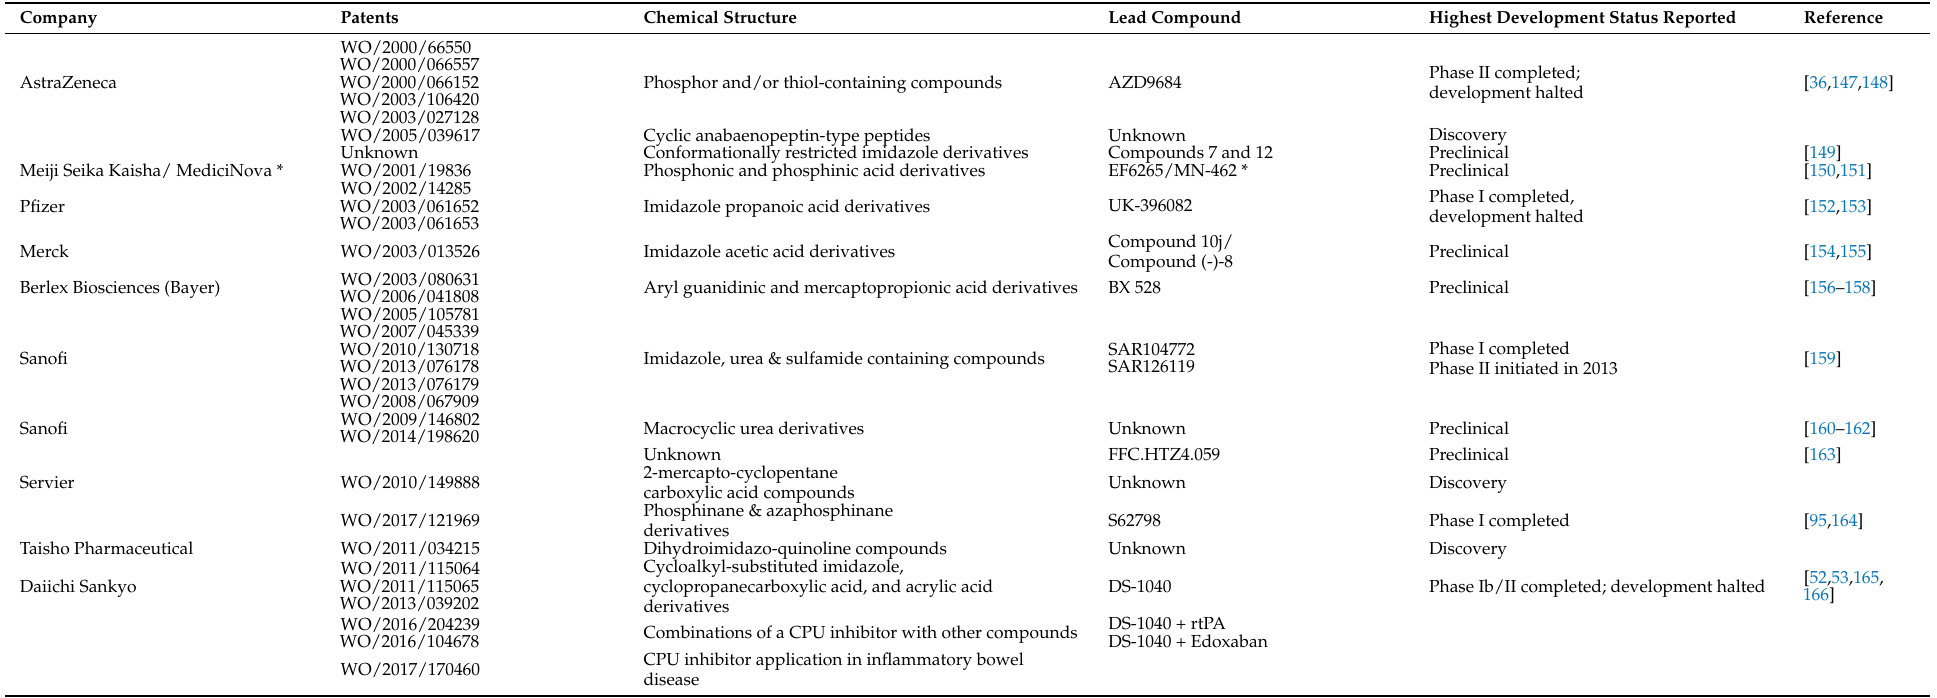
Table 4. Filed patents for CPU inhibitors with their corresponding lead compounds and highest development status